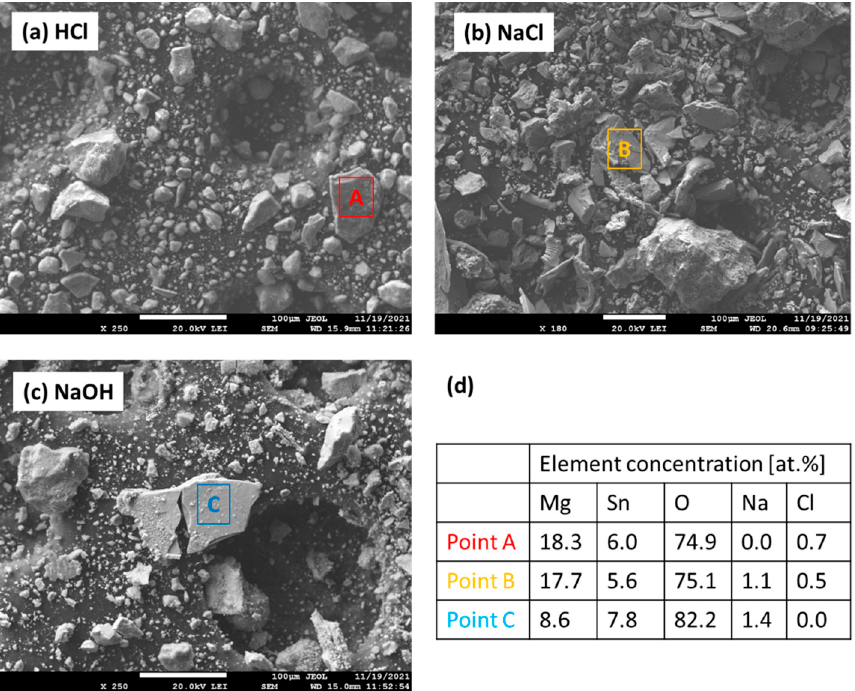
Figure 12. SEM images of Mg 2 Sn alloy corrosion products in NaCl (3.5 wt.%), ( a ), HCl (0.1 wt.%), ( b ) and NaOH (0.1 wt.%), ( c ). EDS analysis of points A–C is presented in ( d ).